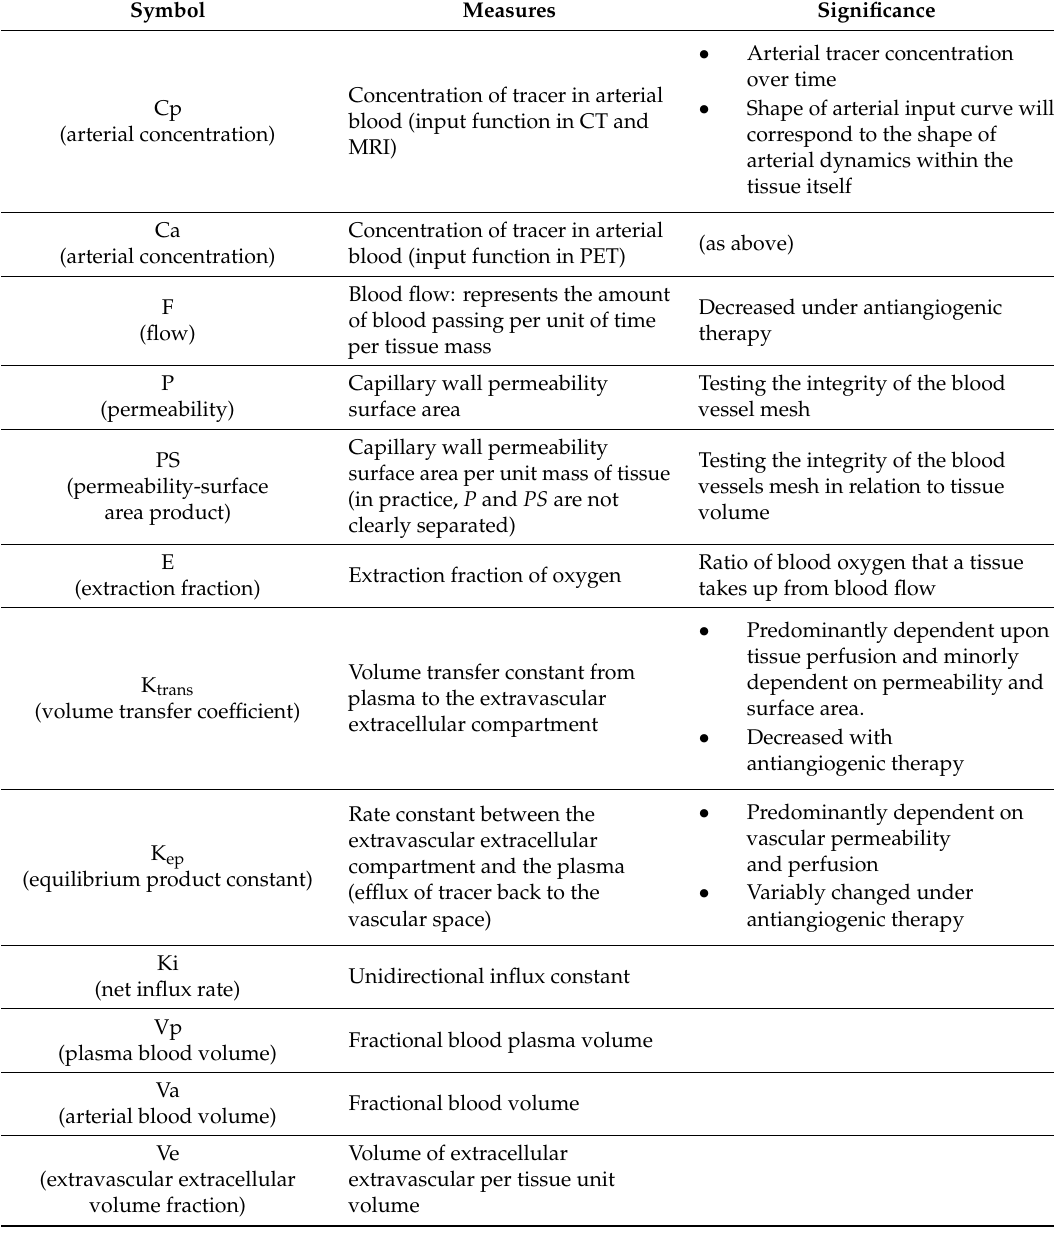
Summary of the measured and calculated hemodynamic parameters and their clinical